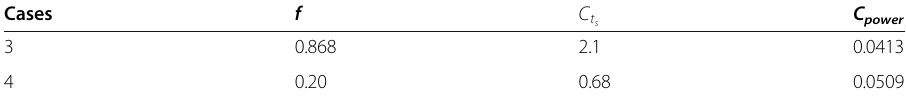
Table 5 Comparison of dominant fluctuation frequency and dimensionless torque and power coefficient of the rotating Magnus rotor with different aspect ratios